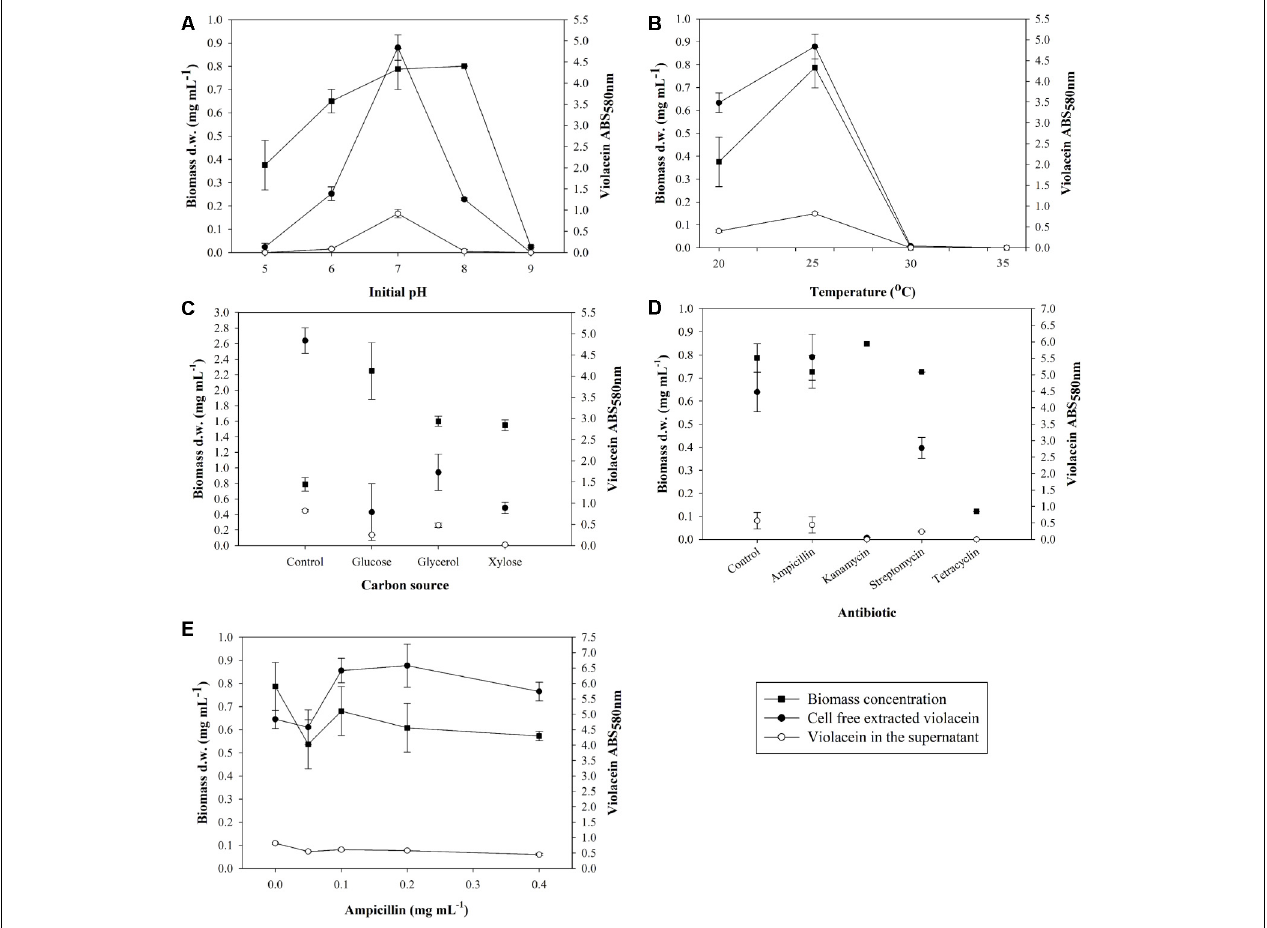
FIGURE 1 | Effect of (A) initial pH, (B) temperature, (C) carbon source, (D) antibiotics, and (E) ampicillin on biomass concentration of J. lividum and crude violacein production cell-free extracted and leaked in the